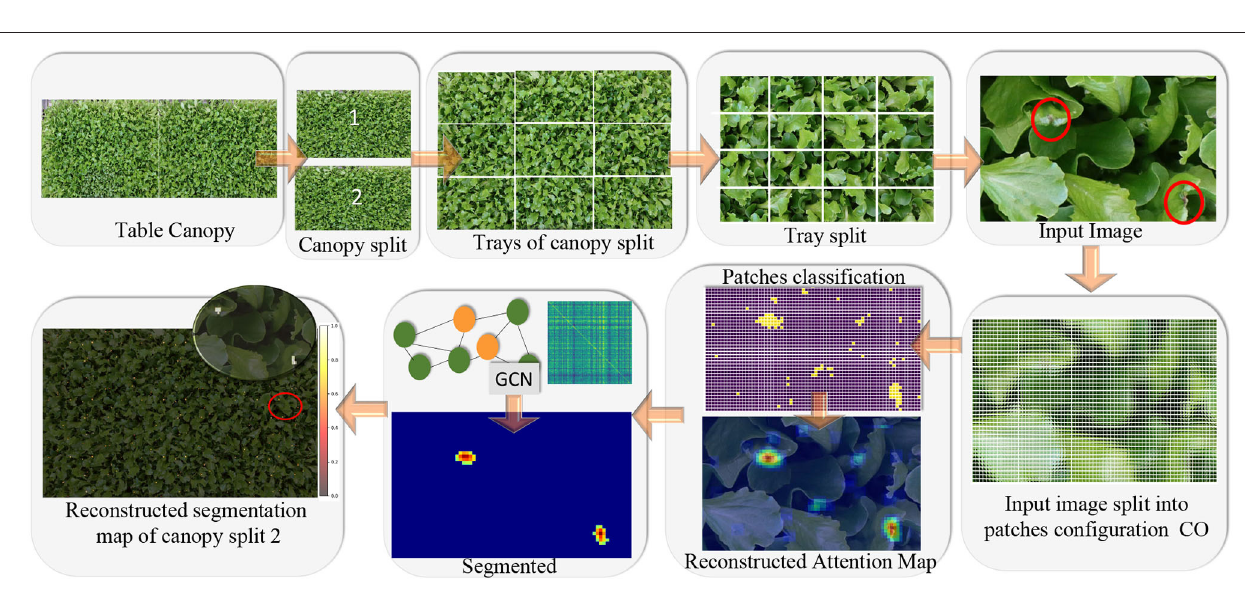
probability vector for the class C given X , as estimated by the softmax